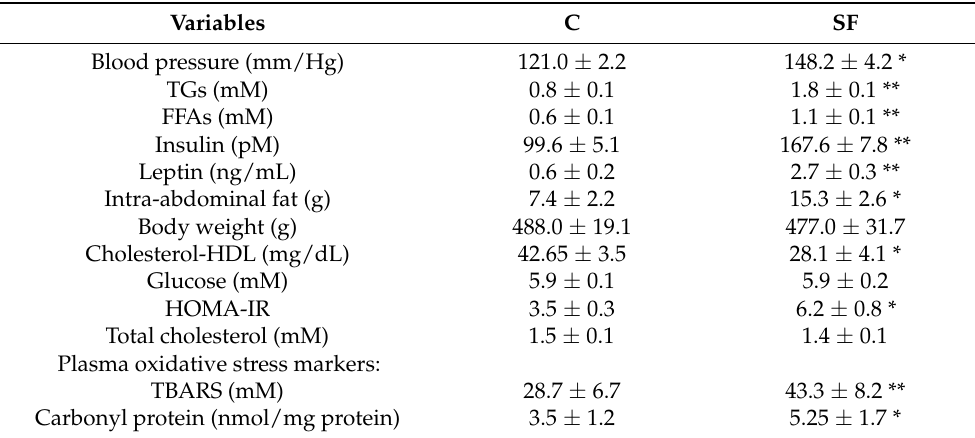
Table 1. General characteristics of